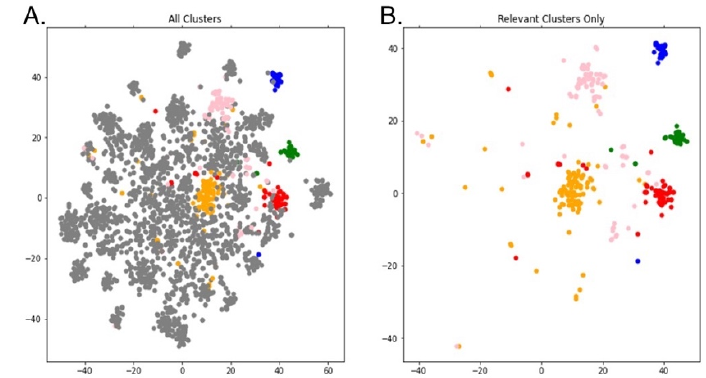
Figure 4. K-means topic clustering of text from downloaded published chronic myeloid leukemia (CML) tyrosine kinase inhibitor (TKI) abstracts. ( A ) Visual representation of the full k-means clus- tering output. Gray dots represent abstracts unrelated to specific TKIs. The colored dots represent abstracts in the clusters pertaining to five TKIs: bosutinib (blue), imatinib (gold), ponatinib (green), dasatinib (red), and nilotinib (pink). ( B ) Output of the k-means clustering algorithm showing the most relevant abstracts and